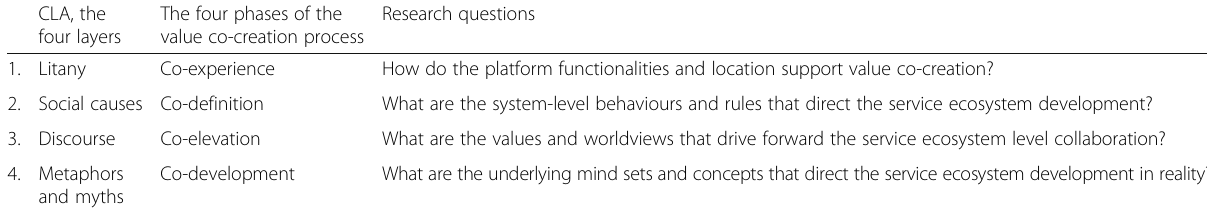
Table 2 Research